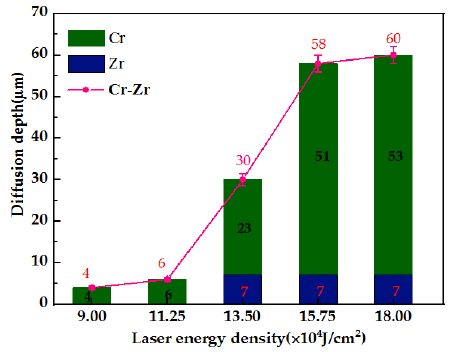
ff usion depth. Figure 7. Diffusion depth. Figure 7. Di